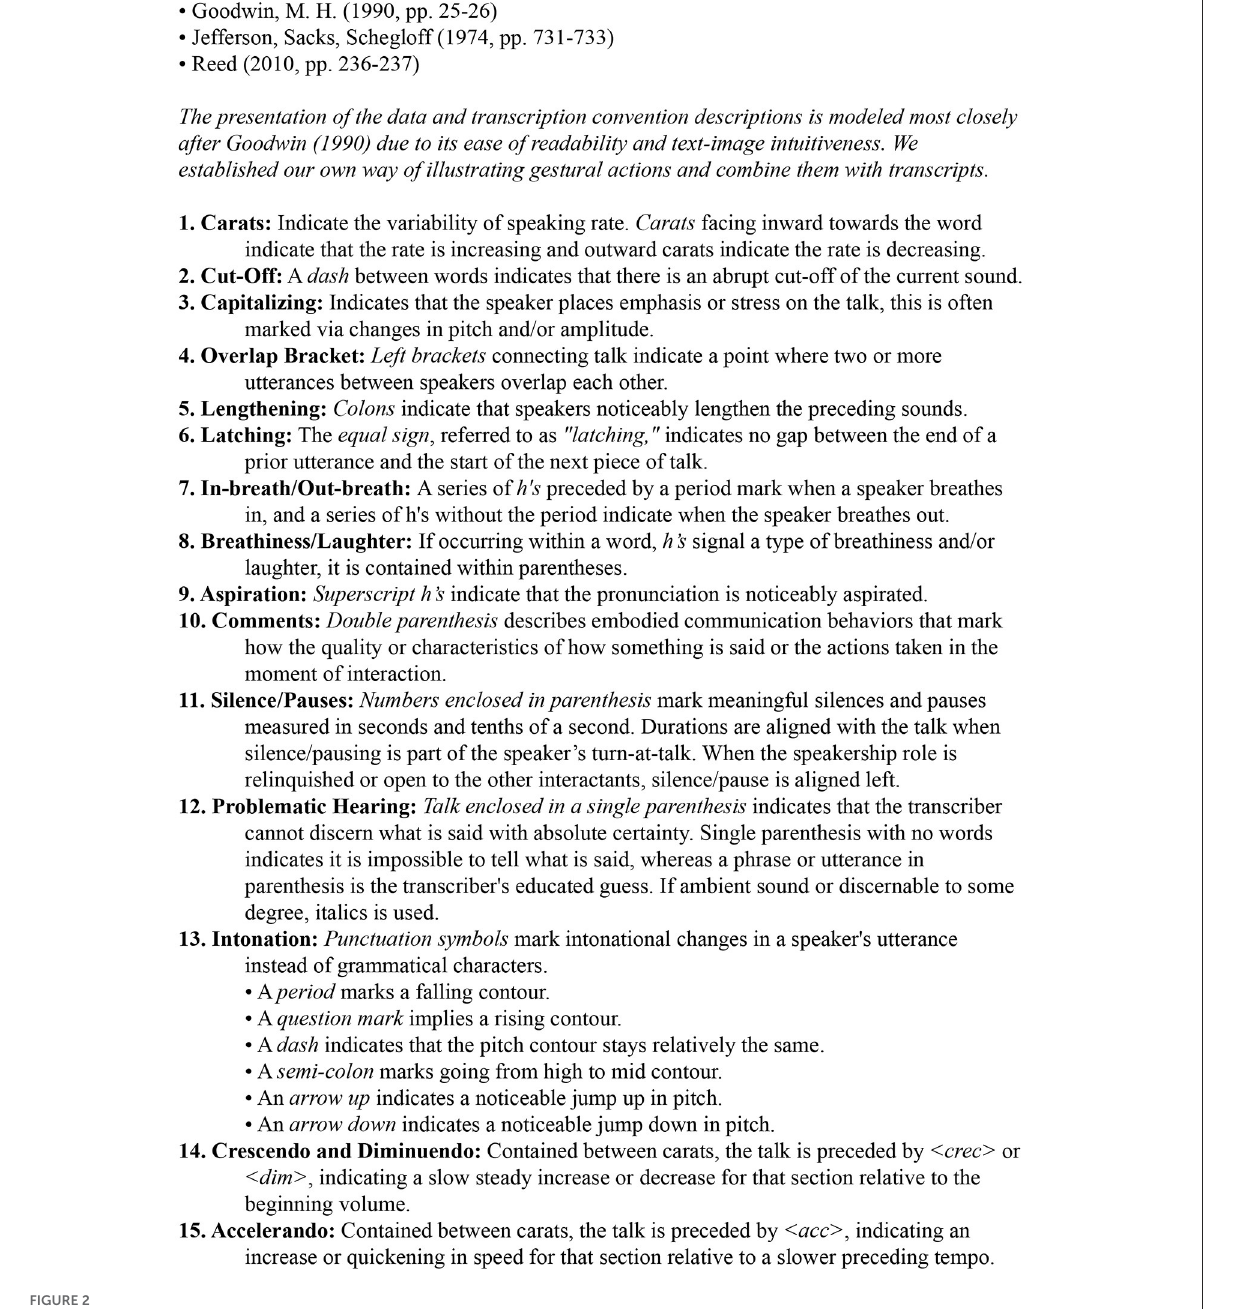
FIGURE2 Transcript